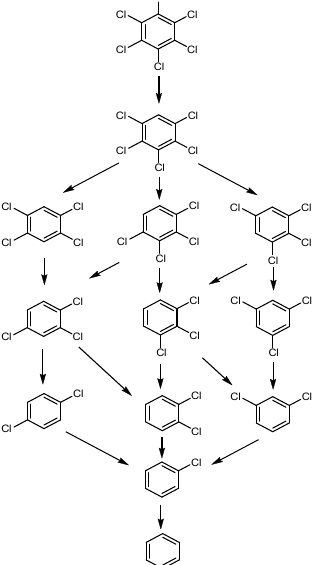
Figure 3. The proposed pathway of hexachlorobenzene and (poly)chlorinated benzenes HDC using studied Al alloys.